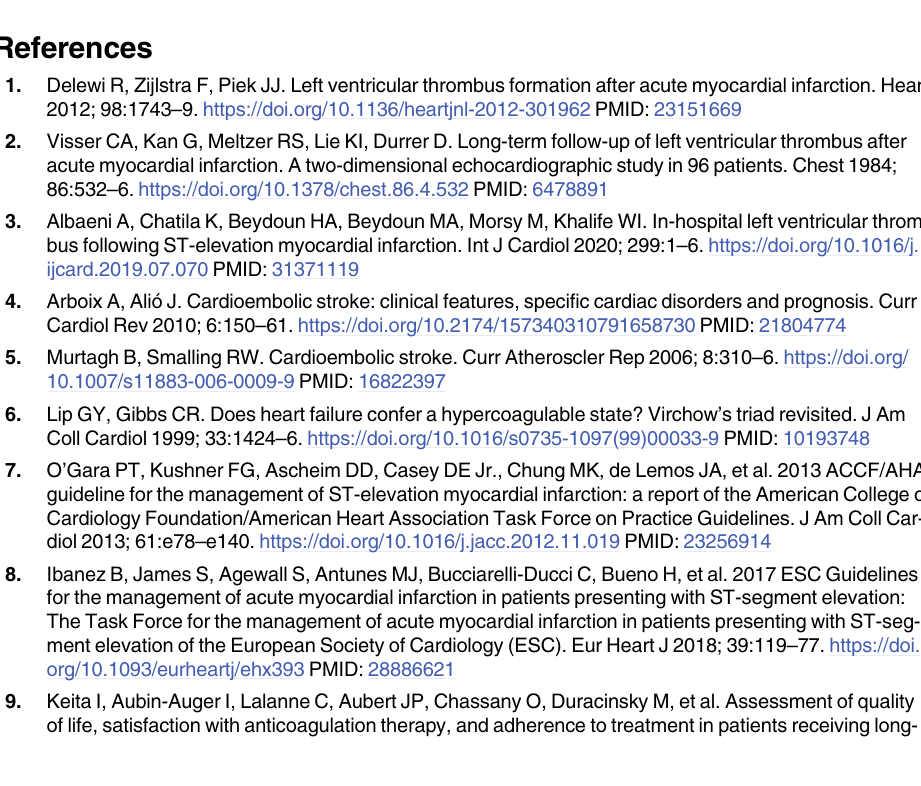
S1 Table. Newcastle-Ottawa quality assessment of the included